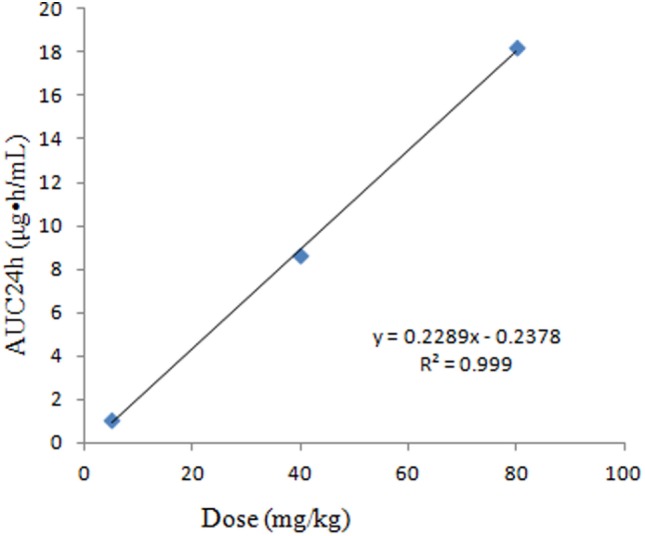
Linear regression plots between administered dose and AUC24h values.